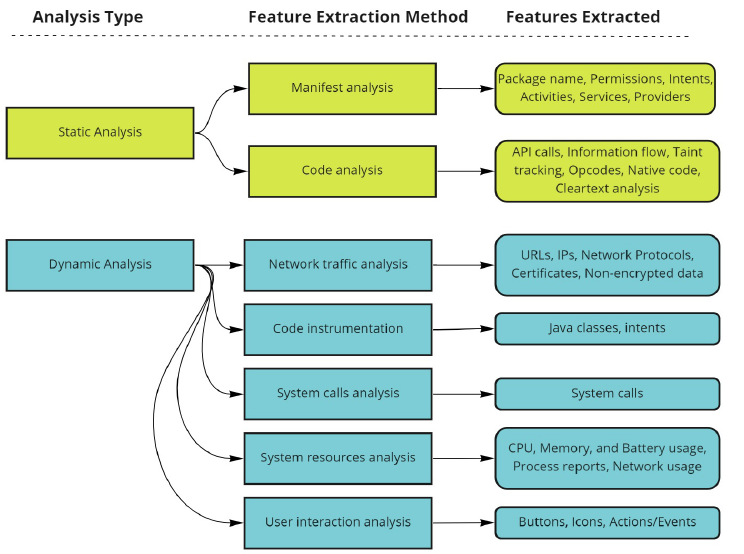
Figure 2. Static and Dynamic Analysis